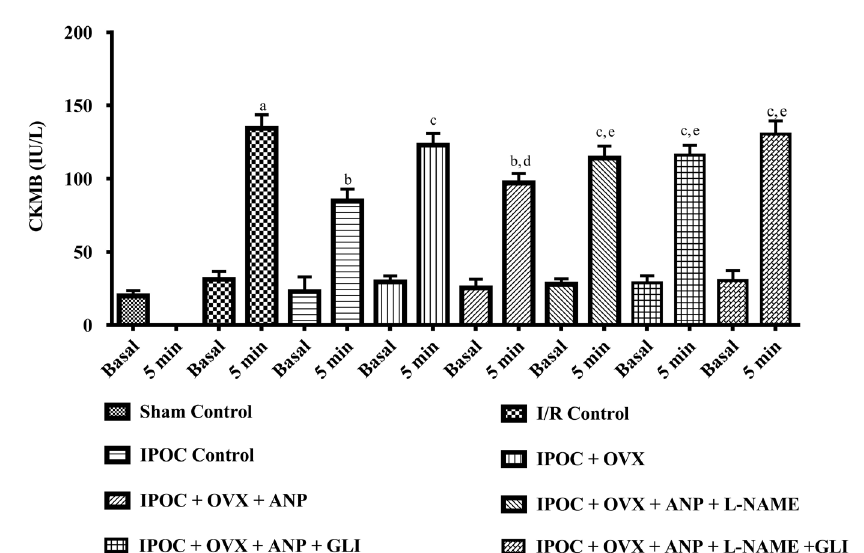
FIGURE 9 - Effect of I/R on release of CK-MB, effect of IPTC on release of CK-MB in normal and OVX rat heart, effect of ANP perfusion, effect of L-NAME and ANP perfusion, effect of Glibenclamide and ANP perfusion and effect of L-NAME, Glibenclamide and ANP perfusion on release of CK-MB in OVX rat heart. I/R denotes ischemic reperfusion; IPTC denotes ischemic postconditioning; OVX denotes ovariectomy; ANP denotes atrial natriuretic peptide; L-NAME denotes N- nitro L-arginine methyl ester.Values are expressed as mean ±S.D, a = p<0.05 vs. sham control; b = p<0.05 vs. I/R control; c = p<0.05 vs. IPTC in normal rat heart; d = p<0.05 vs. IPTC in OVX rat heart; e = p<0.05vs. IPTC in OVX rat heart with perfusion of